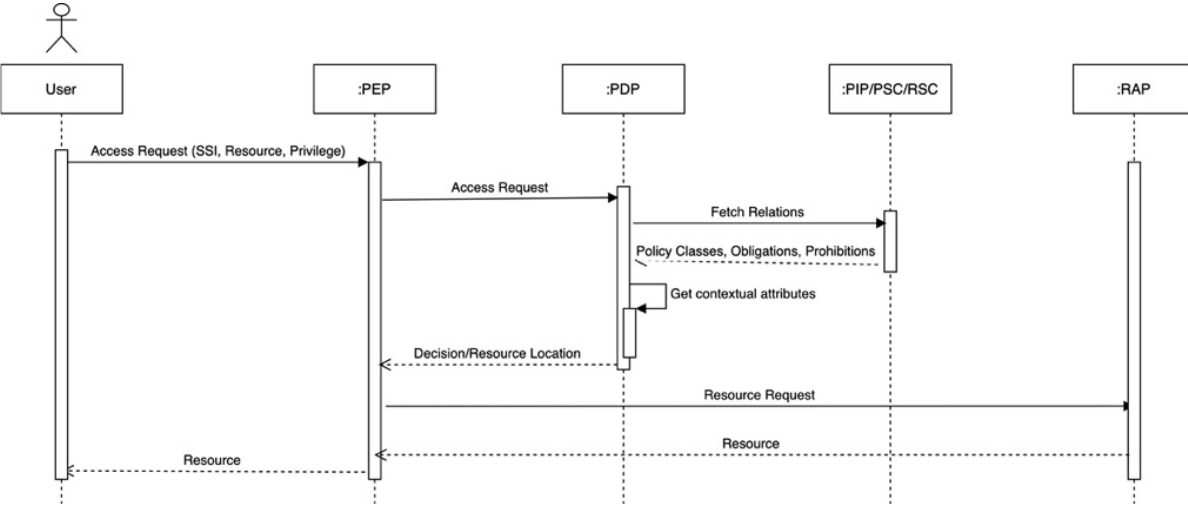
Figure 5. Access request and decision-making flow.